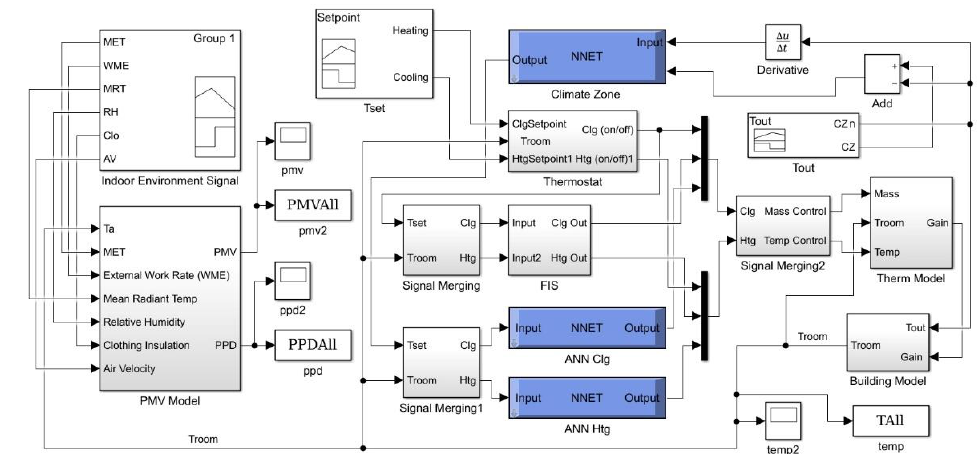
Figure 4. Simulation block